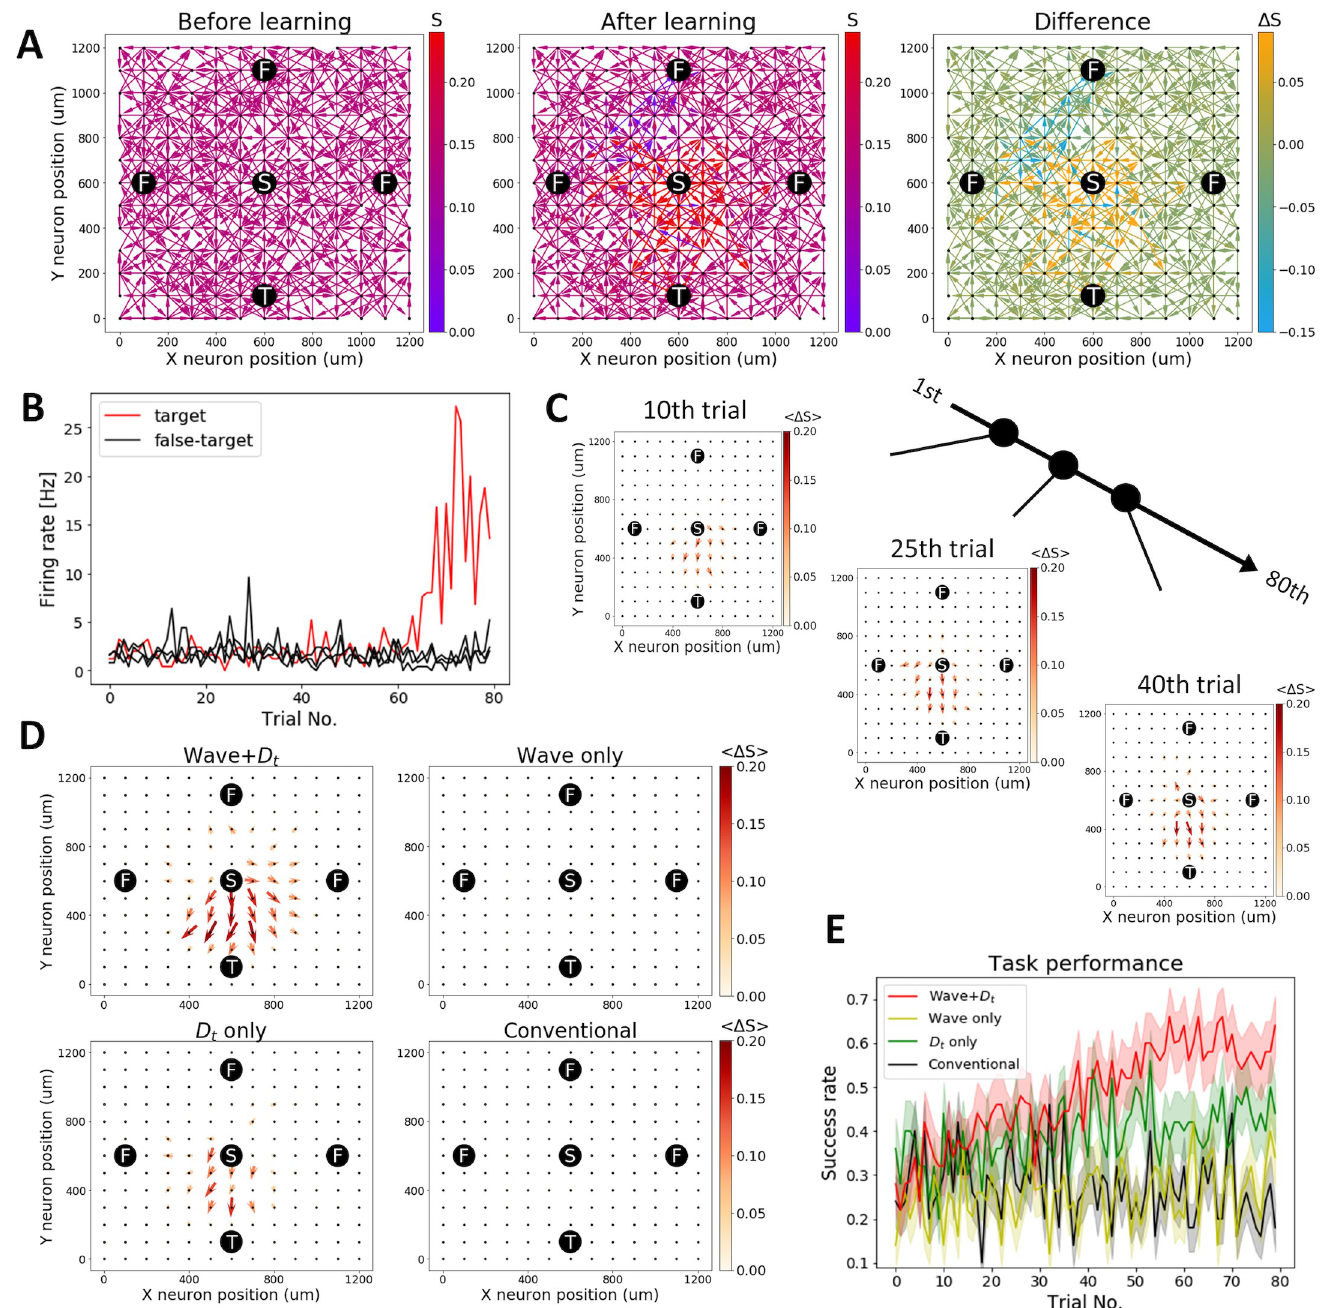
Fig 2. Upstate propagation improves the reinforcement task of poly-synaptic paths. (A) An example of a successful trial. The initial synaptic weights are p represented in color (Left). All neurons are aligned in a grid with 100 μ m spacing, and the adjacent neurons within 200 2 μ m are randomly connected with a probability of 0.5. Synaptic connections from stimulated neuron S are all outward, while the synaptic connections to target neuron T and false-target neurons F are all inward. The path from S to T is selectively strengthened at the end of the learning (Middle). The difference between the initial synaptic weight and the final synaptic weight (Right). (B ) A successful example of this task. The firing rate of the target neuron selectively increases. (C) The averaged synaptic weight difference from the initial condition to the 10 th , 25 th , 40 th trials is plotted. The averaged synaptic weights are calculated, including the direction of synaptic weights (so that the opposite direction has a minus sign). (D) The averaged synaptic weight difference between the initial trial and the last trial (the 80 th trial) is plotted. (E ) The success rate of each condition (50 simulations averaged). The shaded area indicates the standard error of the mean. A combination of wave and tonic dopamine signal D t (red line) shows the best task performance, while the conventional model (black line) fails to complete this task.